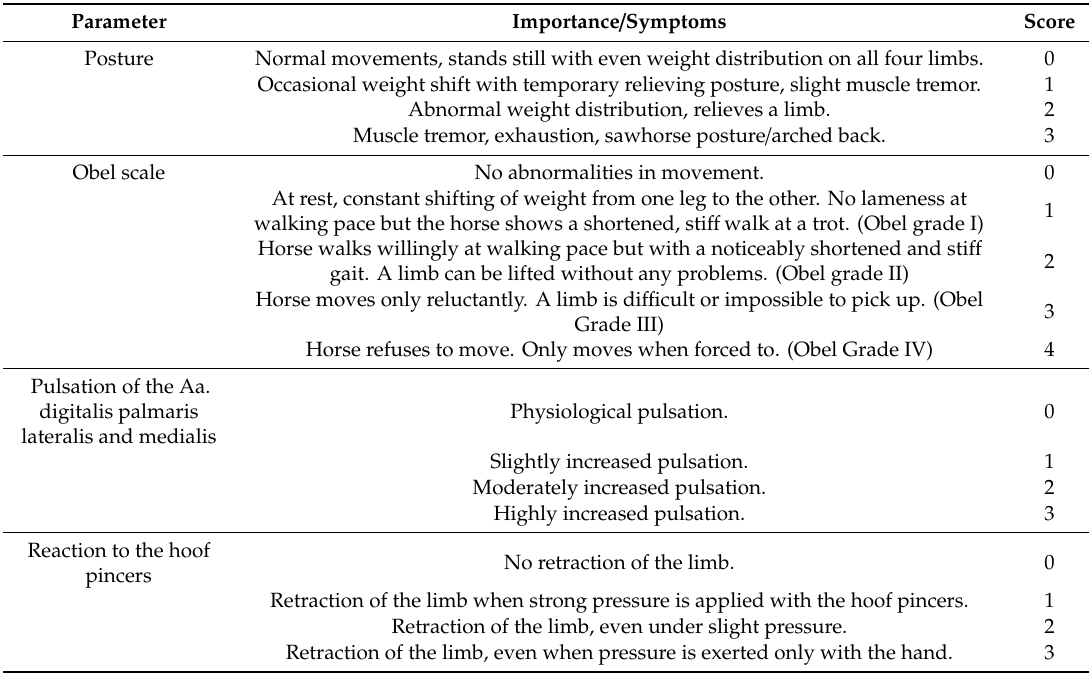
Table3. Painscaletodeterminetheintensityofthepain. Additionalparametersforhorseswithlaminitis.